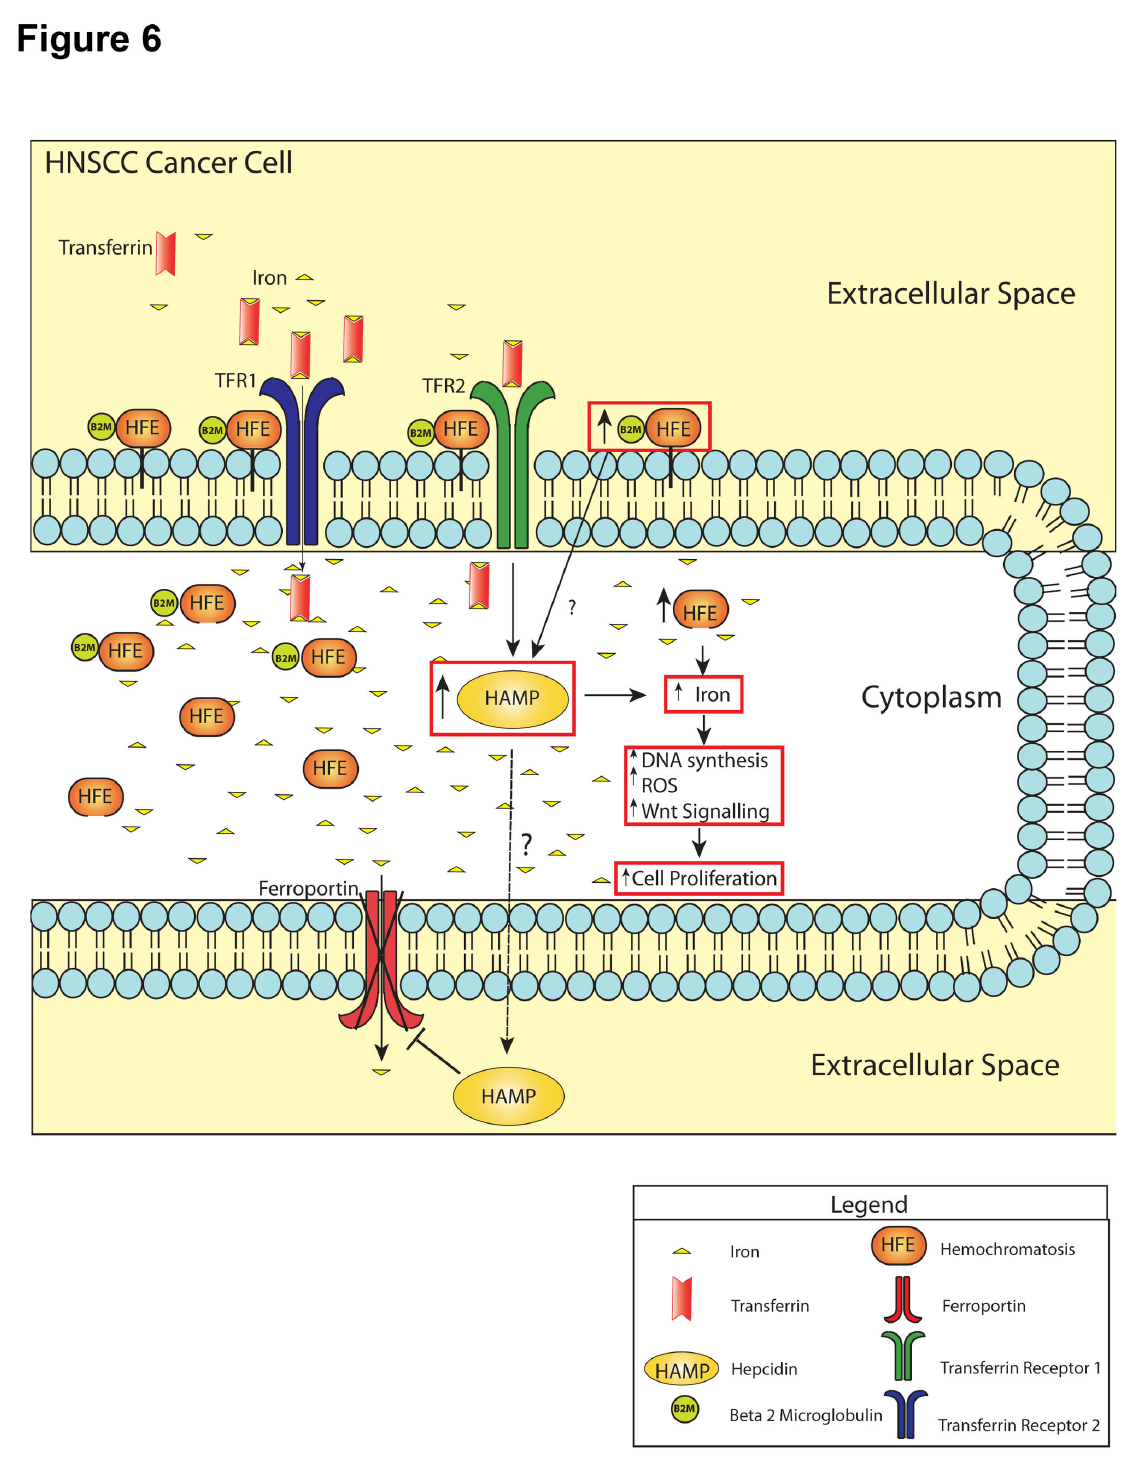
Figure 6. Proposed model for the role HFE in promoting HNSCC progression via iron regulation. Schema showing that HFE overexpresion leads B2M binding for cell membrane trafficking. HFE increases HAMP either directly or via TFR2. HAMP then exits the cell, through an unknown mechanism, and in turn degrades FPN, which leads to iron accumulation. Collectively, this results in increased DNA synthesis, elevated ROS, and Wnt signaling, all driving tumour cell proliferation and clonogenicity. Boxes in red denote the data demonstrated in this current study. doi: 10.1371/journal.pone.0074075.g006 PLOS ONE |